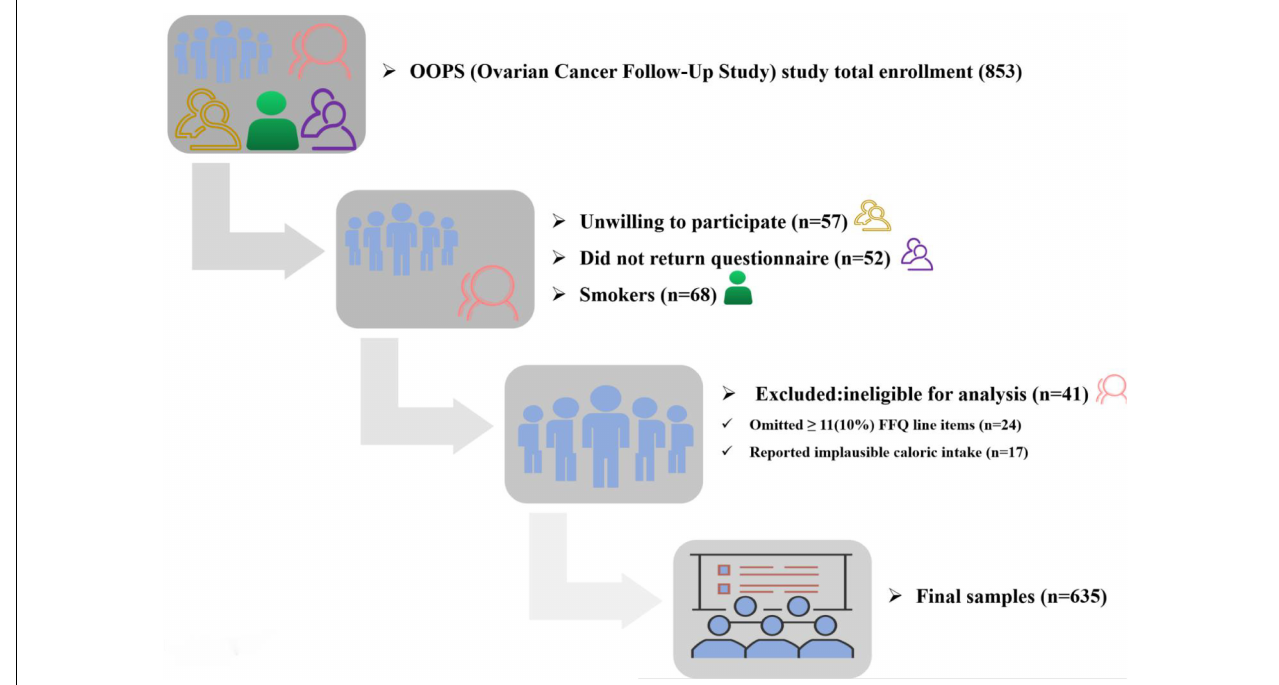
FIGURE 1 | Flow of participants through